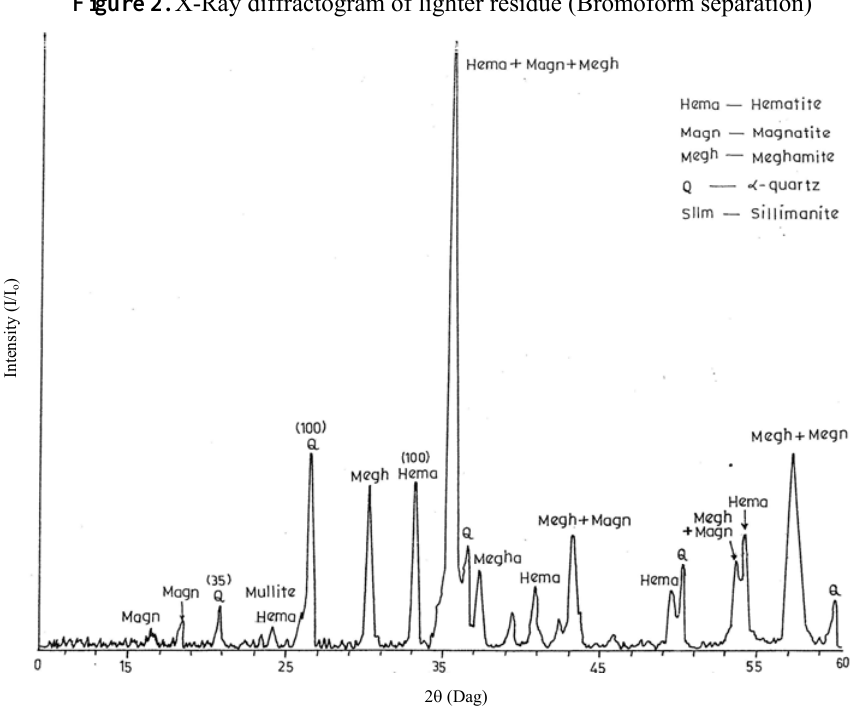
Figure 3. X-Ray diffractogram of heavy portion (Magnetic) (Bromoform